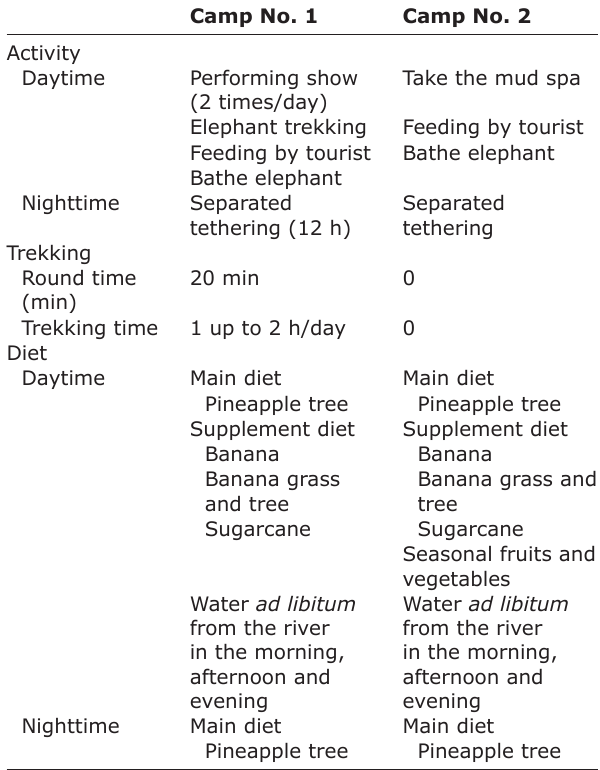
Table-1: Description of the activities and diet of elephants that participated in this study. Camp No.